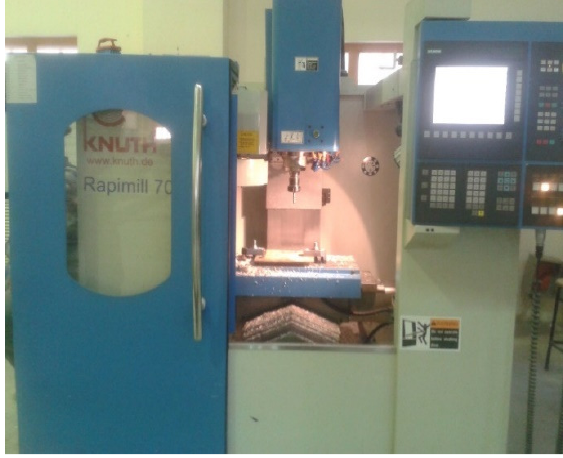
Fig. 1. Cutting tool CNC machine